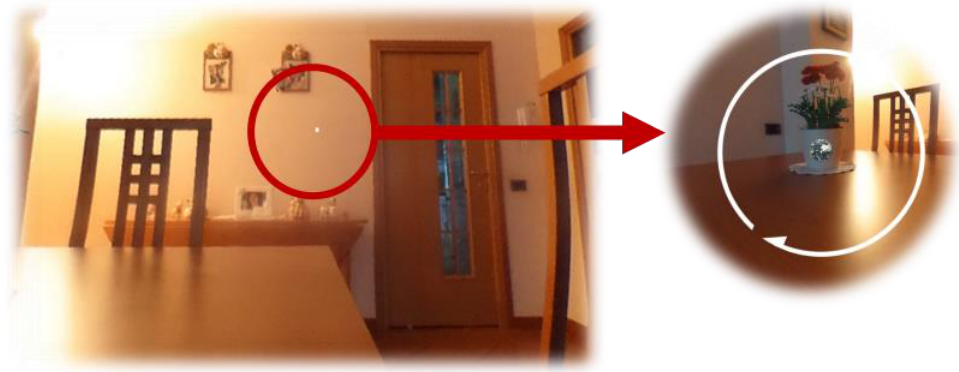
Figure 2. The representation of the small white dot that participants see in the headset. To respond, participants must move their heads and position the dot on the answer for a few seconds and the answer will be selected automatically.